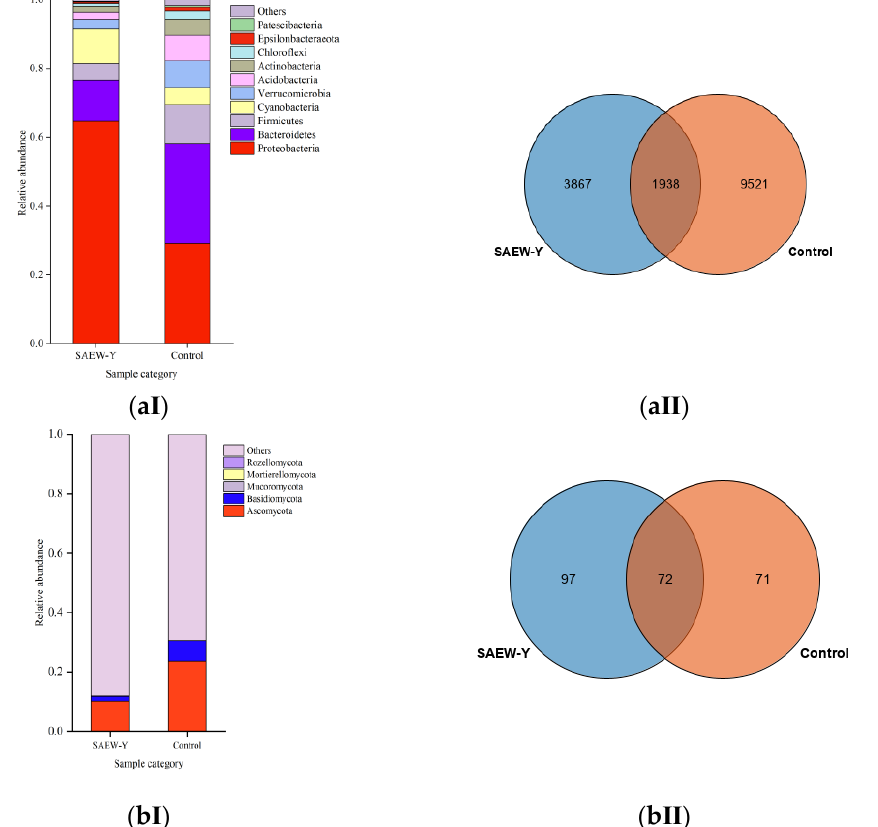
Figure 2. Taxa relative abundance in phylum level for ( a Ⅰ ) bacterial 16S and ( b Ⅰ ) fungal ITS regions. Venn diagrams showing the distribution (97% similarity) of the OTUs at genus level present in ( a Ⅱ ) for bacteria and ( b Ⅱ ) for fungi . “Others” represents a total relative abundance of the remaining phyla besides the top 10 phyla. Control- tempering weilong-169 wheat grains (Y) with distilled water, SAEW-Y- tempering weilong-169 wheat grains with SAEW, optimal volume ratio 6.5:10, respectively, at the same conditions.